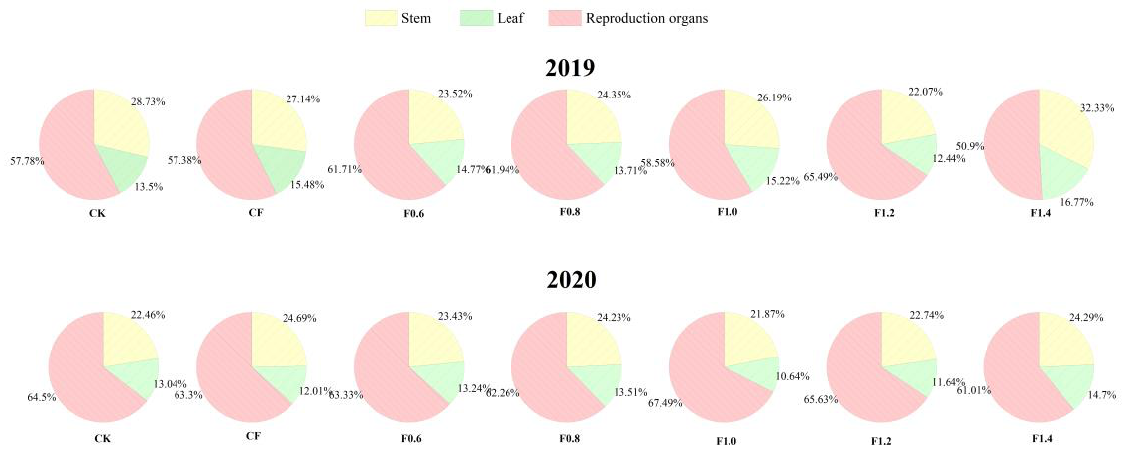
Figure 6. Distribution of K in different organs under different fertilization patterns during